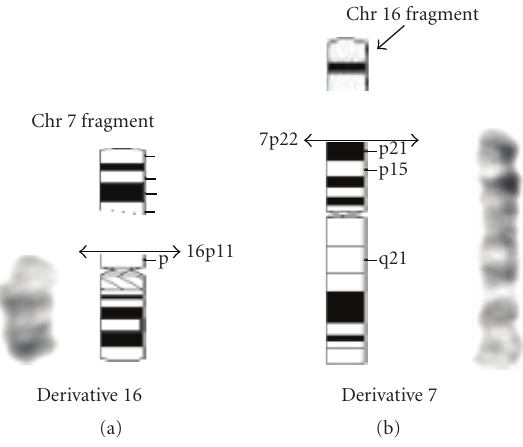
Figure 2: Partial GTG-banding karyotype of the patient. The patient derivative chromosomes 7 and 16 are shown. By comparing both respective ideogrammed chromosomes, the breakpoints were located in 7p22 and